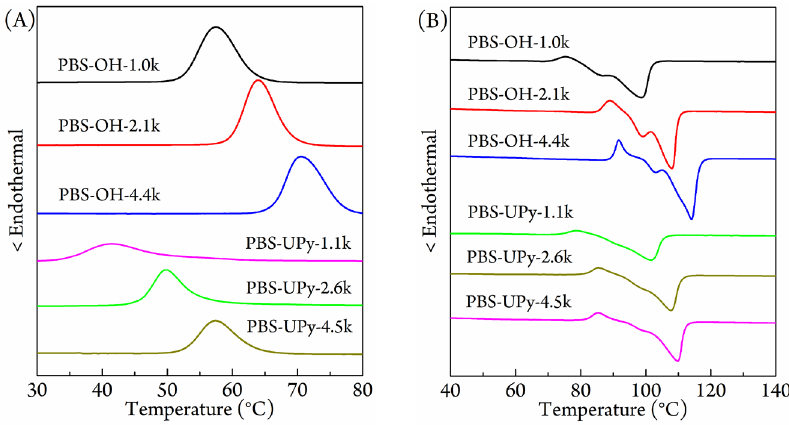
Figure 4. DSC thermograms of PBS-OH and PBS-UPy samples being cooled from melts ( A ) and the subsequent heating process at a rate of 10 °C/min ( B ). Table 2. Crystallization peak temperatures ( T c ), crystallization enthalpy ( ∆ H c ), melting temperatures ( T m ) and melting enthalpy ( ∆ H m ) of PBS-OH and PBS-UPy samples during the melt-cooling and reheating process with a rate of 10 ◦ C/min. The enthalpy values of PBS-UPy samples were obtained by dividing the as-measured enthalpies by the mass fraction of PBS in